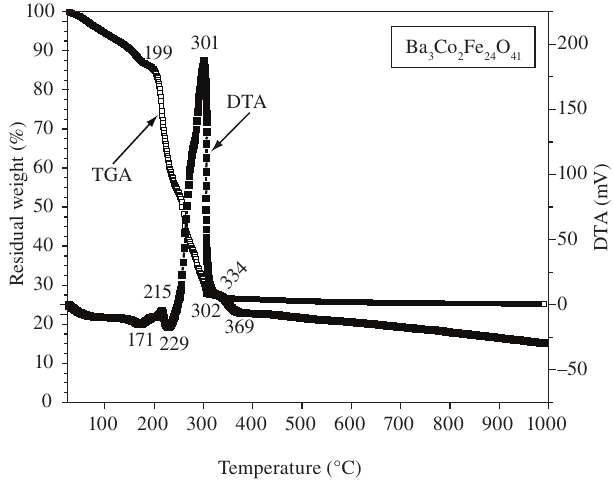
Figure 2. DTA and TGA curves for the metal citrate precursor behavior during heating, in air with heating rate of 10